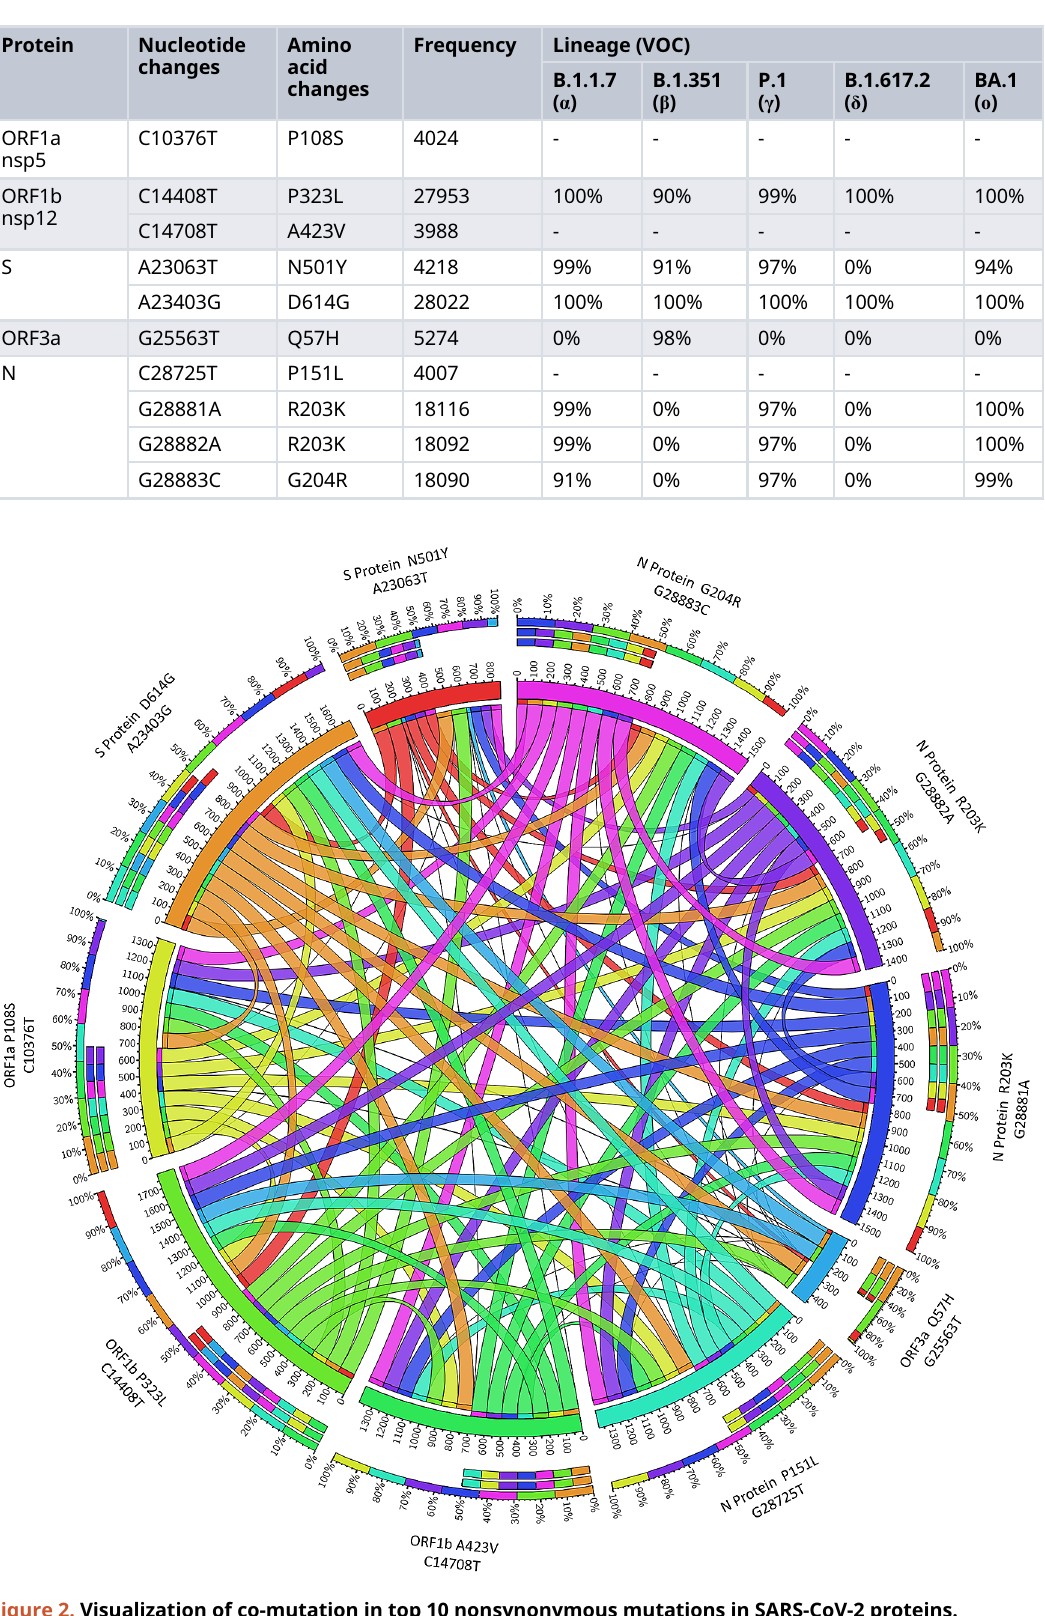
Figure 2. Visualization of co-mutation in top 10 nonsynonymous mutations in SARS-CoV-2